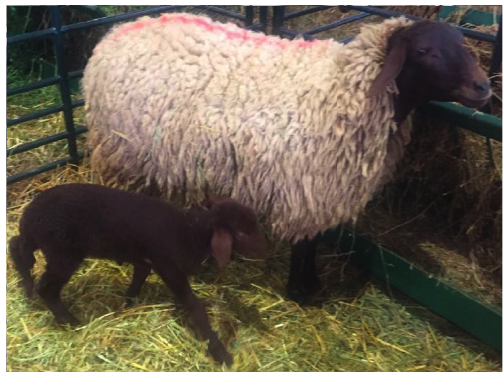
Figure 1: Ewe of Beni-Guil breed (18 months old) with its lamb.